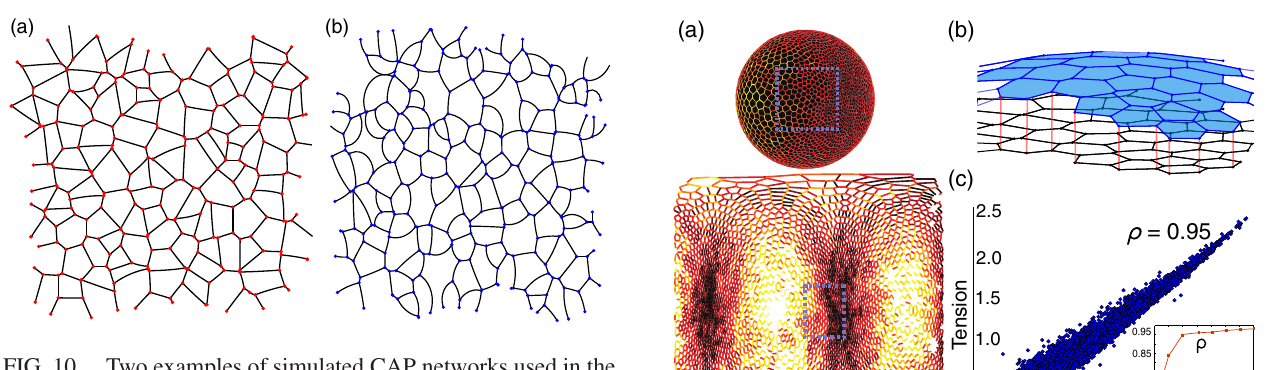
FIG. 10. Two examples of simulated CAP networks used in the in silico verification presented in Appendix D with varying average pressure differences. Networks (a) and (b) were gen- erated with varying degrees of intracellular pressure differentials. The average edge curvatures, normalized to edge length — i.e., R =r — for (a) and (b) are 0.01 and 0.20, respectively. αβ αβ